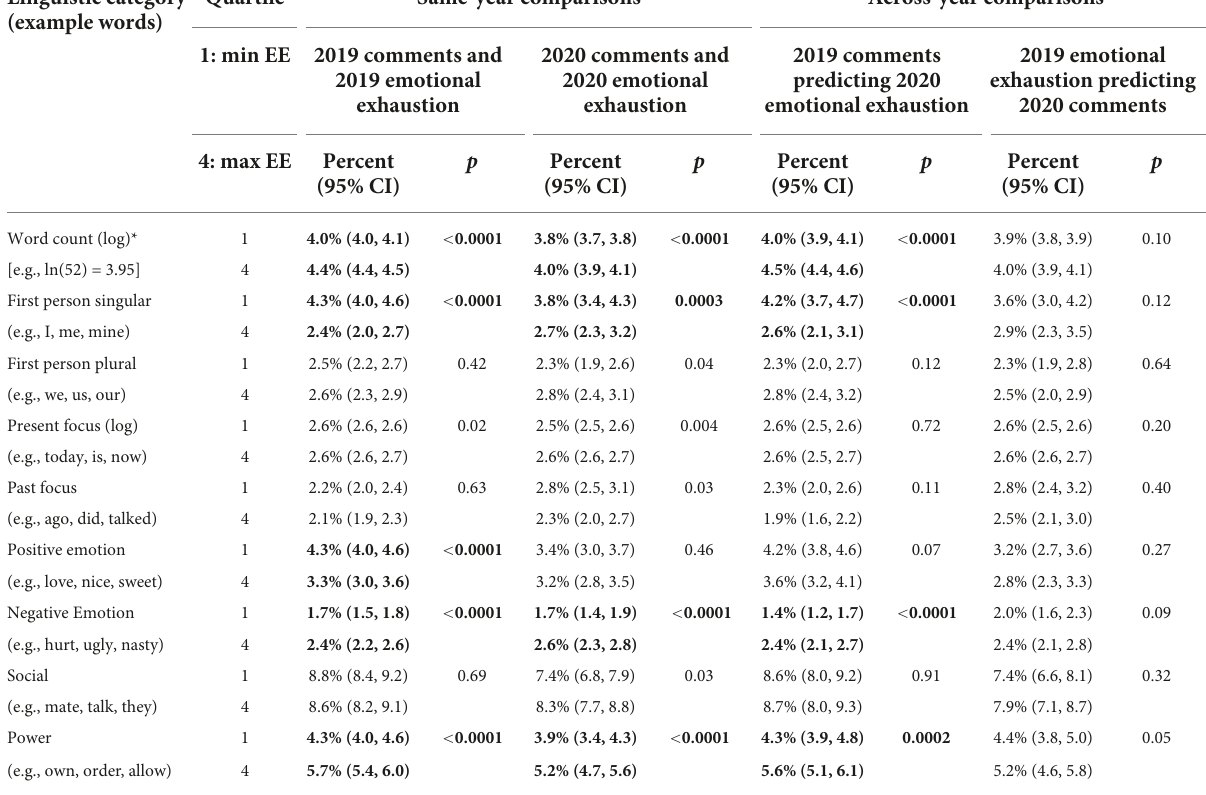
TABLE 2 Pair-wise associations between the frequencies of nine linguistic categories in healthcare worker (HCW) comments across levels of emotional exhaustion (EE). Linguistic category (example